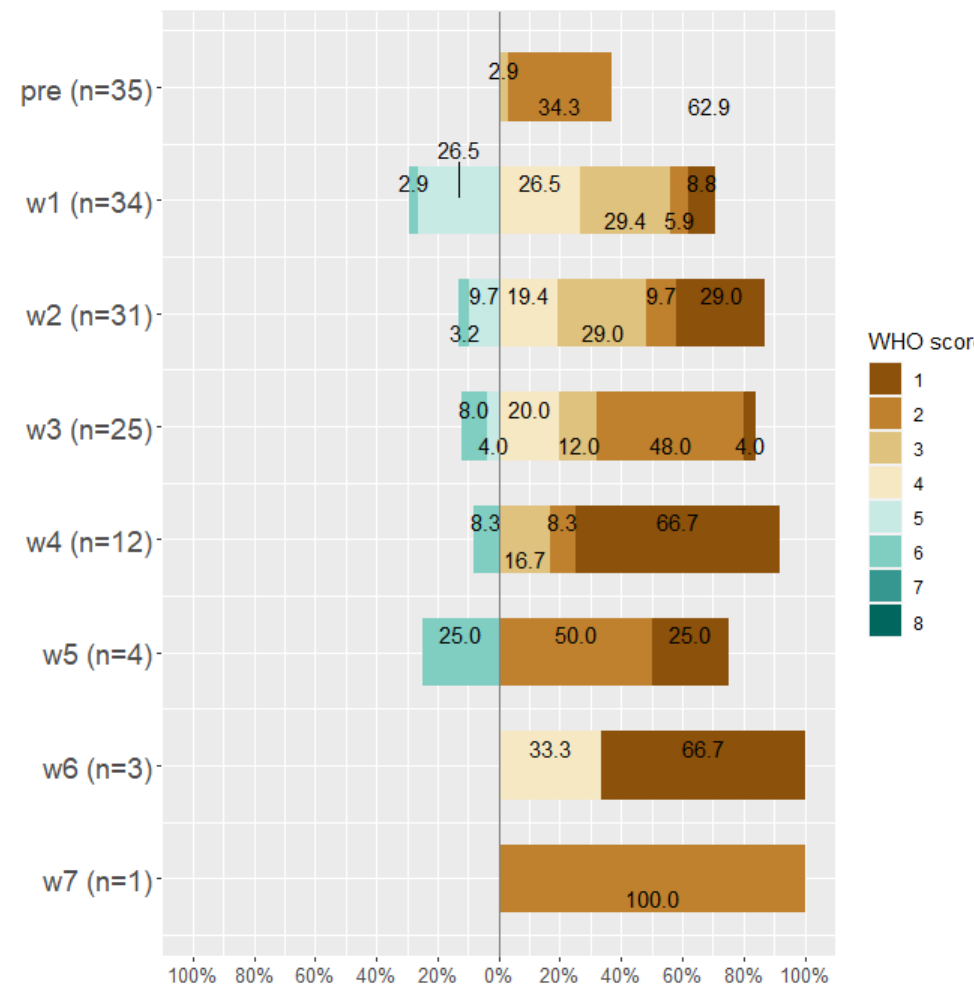
Figure 4. WHO score for improved patients ( n = 35) before taking Tocilizumab and at weeks 1, 2, 3, 4, 5, 6, and 7 after Tocilizumab administration.